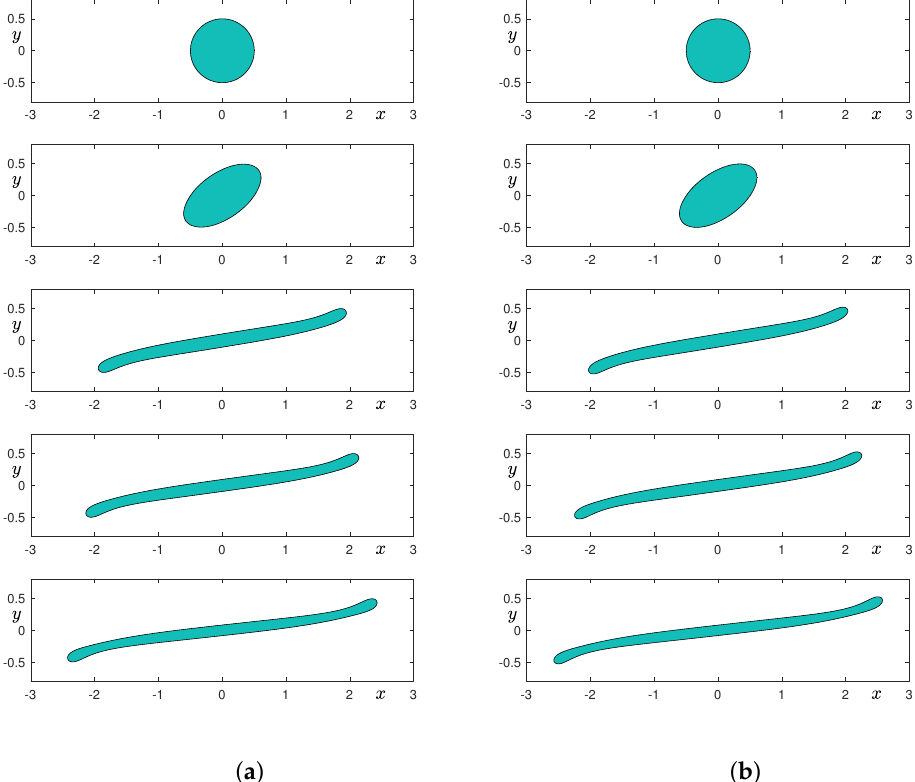
Figure 5. Temporal evolution of a droplet in shear flow: ( a ) 384 × 128 grid and ( b ) 768 × 256 grid. From top to bottom, times are at t = 0, 0.7, 5.25, 5.95, and 7.